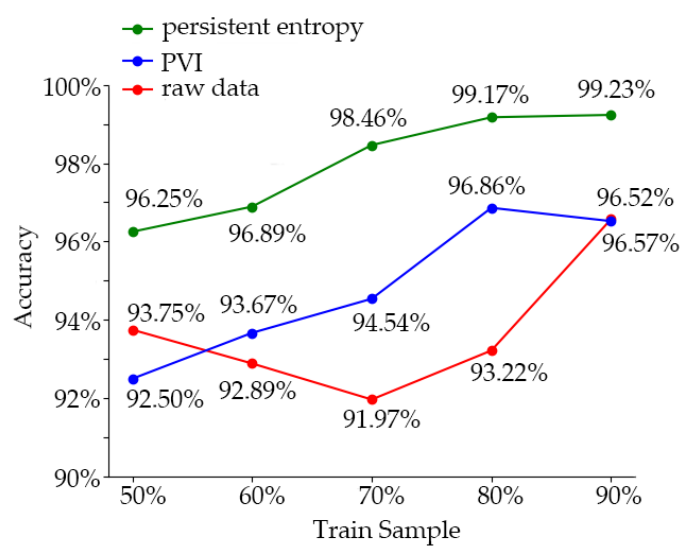
Figure 8. The training accuracy of the raw data, permutation-variable importance processing and persistent entropy. Table 8. Comparison with other methods.